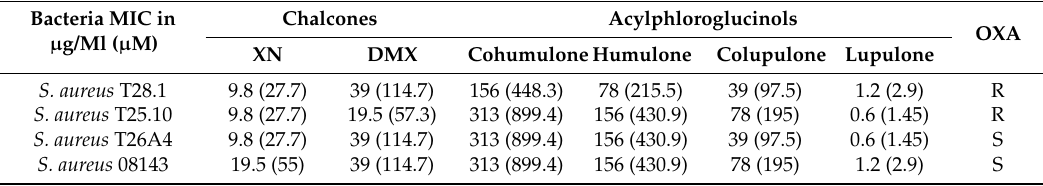
Table 3. MIC of hop chalcones and acylphloroglucinols against selected MRSA (T28.1 and T25.10) and MSSA (T26A4 and 08143) strains.